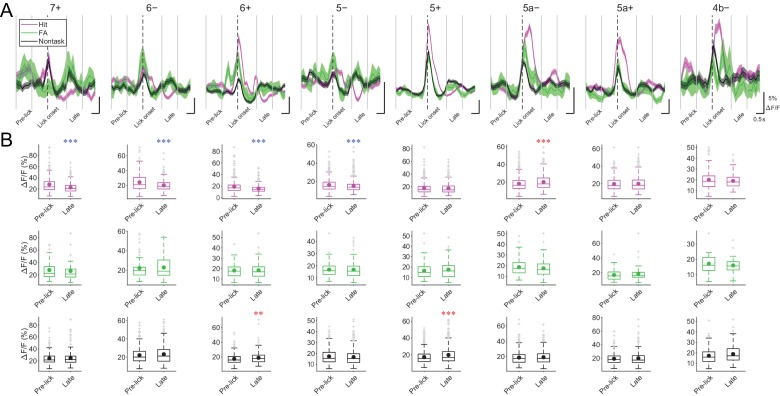
CF signals at late timing during licking trials and nontask licking epochs.(A) ROI-averaged ΔF/F traces from single compartments in single licking trials (hit and FA) and nontask licking epochs were classified by trial types and averaged across sessions and animals. Thick colored lines represent means and the shadings represent s.e.m. Vertical dashed lines represent lick onset, and gray solid lines represent the edges of response windows. (B) Averaged ΔF/F value within each response window per trial for each trial type and epoch pooled across sessions and animals (hit, FA trials and non-task licking epochs; 7+, n = 5 mice, 240, 45, and 202 trials and epochs; 6−, n = 6 mice, 360, 59, and 281 trials and epochs; 6+, n = 10 mice, 435, 58, and 352 trials and epochs; 5−, n = 12 mice, 667, 94, and 460 trials and epochs; 5+, n = 12 mice, 761, 108, and 548 trials and epochs; 5a−, n = 10 mice, 631, 101, and 551 trials and epochs; 5a+, n = 3 mice, 365, 66, and 322 trials and epochs; 4b−, n = 2 mice, 143, 23, and 132 trials and epochs). Colored dots represent means and gray crosses represent outliers. Asterisks represent significantly positive (red) or negative (blue) differences compared with pre-trial ΔF/F. One-way ANOVA with repeated measures followed by post-hoc Tukey’s test: **p<0.01, ***p<0.001.